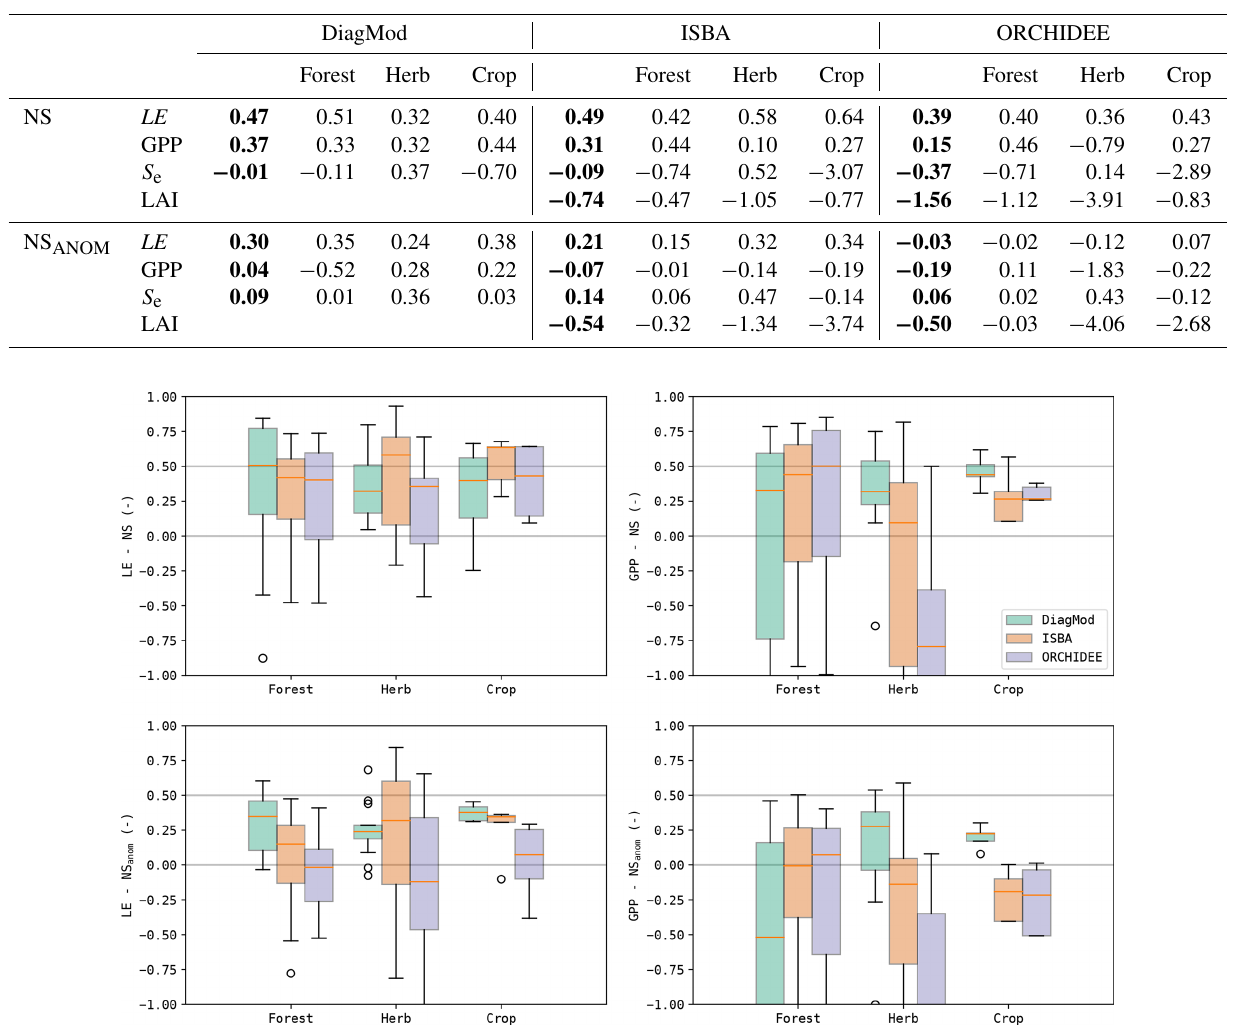
Table 3. Nash–Sutcliffe model efficiency coefficient of LE , GPP, S e and LAI and their seasonal anomalies. Median scores given for all sites and grouped per dominant land cover type. The scores for the DiagMod S e are computed using the ERA5 S e . Overall median scores are given in bold font.